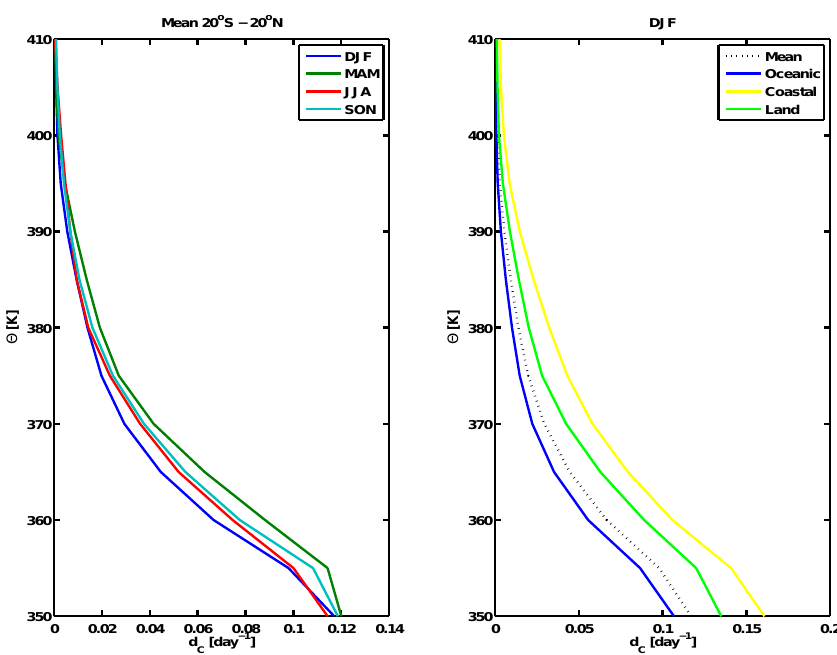
Fig. 3. 20 ◦ S–20 ◦ N zonal mean profiles of ERA-Interim detrainment rates for the seasons in 2000 (left) and source regions for DJF 2000 (right). Other years (and seasons) produce similar results.